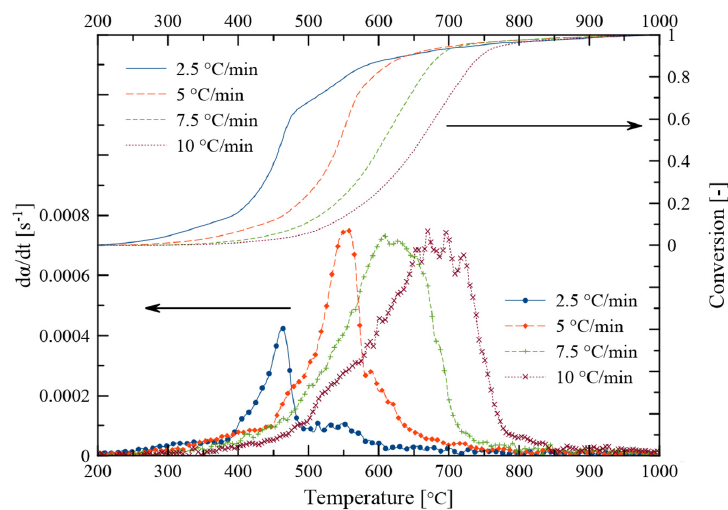
Figure 4. Conversion and conversion rate curves for date seed pyrolysis.